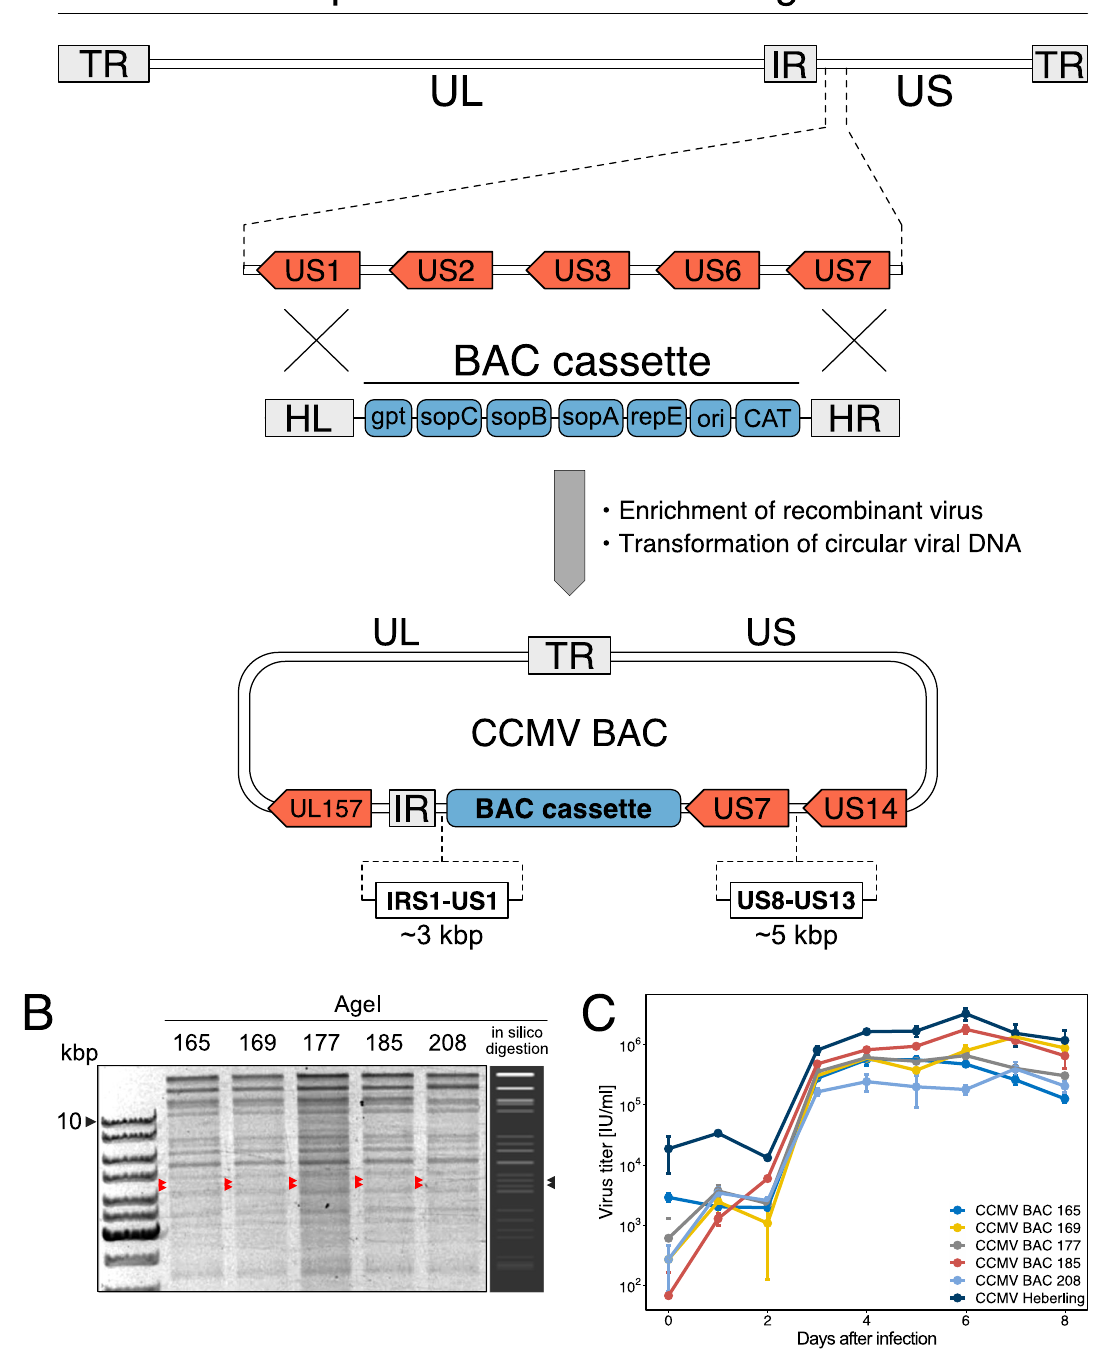
Fig 1. BAC-cloning of CCMV strain Heberling. (A) Targeted integration of the BAC cassette into the CCMV Heberling genome was mediated by homology arms left (HL) and right (HR), replacing the region between US1 and US7. The BAC cassette contains a replication origin (ori), a centromeric region (sopC), genes encoding replication (repE) and partitioning factors (sopA, sopB), as well as resistance genes for eukaryotic (xanthine phosphoribosyltransferase—gpt) and prokaryotic selection (chloramphenicol acetyltransferase—CAT). TR—terminal repeats; UL—unique long region; IR—internal repeats; US—unique short region. (B) Five BAC clones showed an AgeI restriction pattern matching the predicted in silico digest. Arrowheads indicate bands that were missing